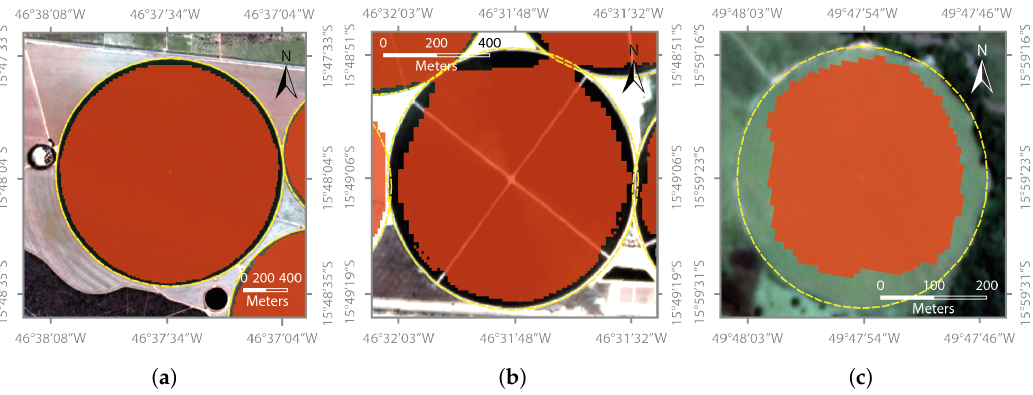
Figure 9. Examples of center pivot irrigation system segmentation using our approach. The yellow dotted lines show the position of center pivot irrigation systems in the reference data, and the results of the automatic mapping using our approach are shown in red. ( a ) Accurate segmentation mask; ( b ) Some pixels at the edge are left out; ( c ) Many pixels at the edge are incorrectly